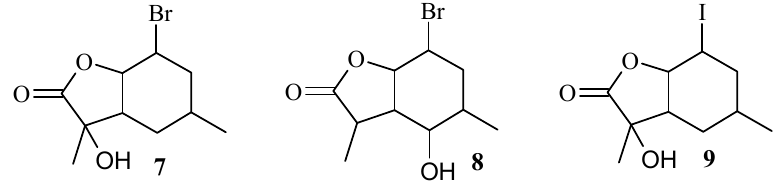
Figure 4. The structures of halo-hydroxylactones 7 –